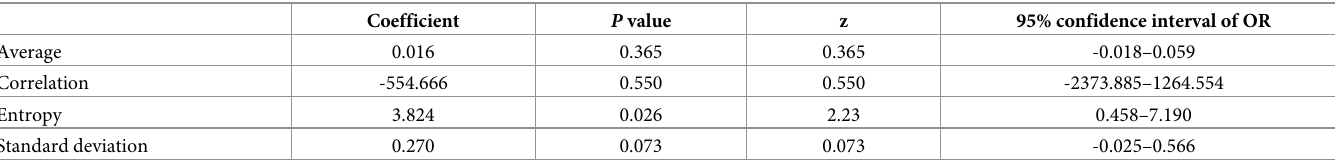
Table 2. Conditional logistic regression model for occult PC in the test cohort.